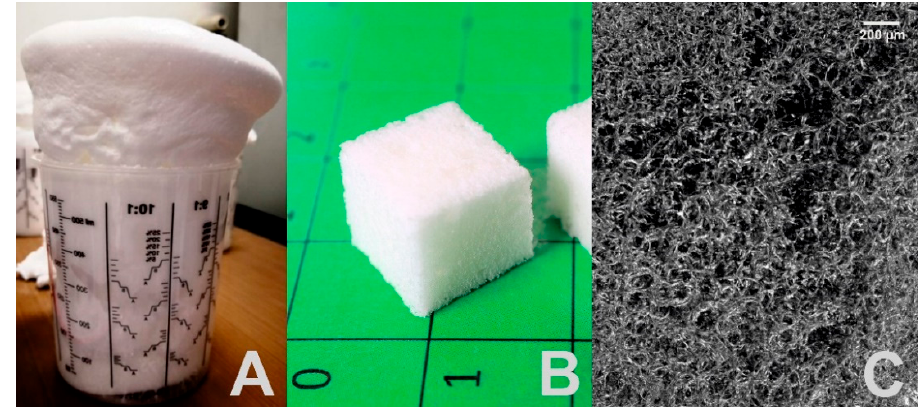
Figure 2. Polyester urethane urea foam: As synthesized ( A ), cube-shaped samples as used for mechanical and thermomechanical characterization ( B ) and µCT image of the foam ( C ).